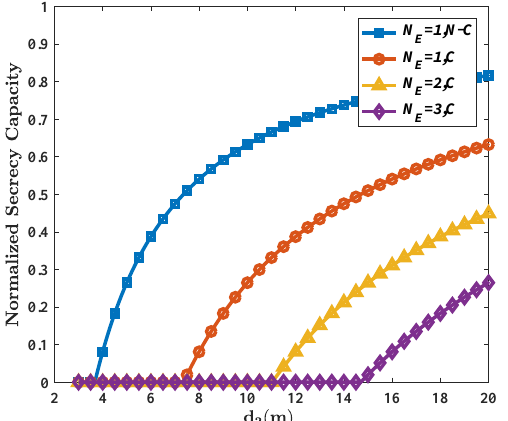
Figure 4. The normalized secrecy capacity as a function of d 2 in the non-colluding and colluding cases. Here, all the eavesdroppers have the same distance d 2 to the PEC and the channel fading is ignored. Other parameters are given by: G = 25 dBi; f = 300 GHz; P = − 10 dBm; R S = 15 m; and d 3 = 1